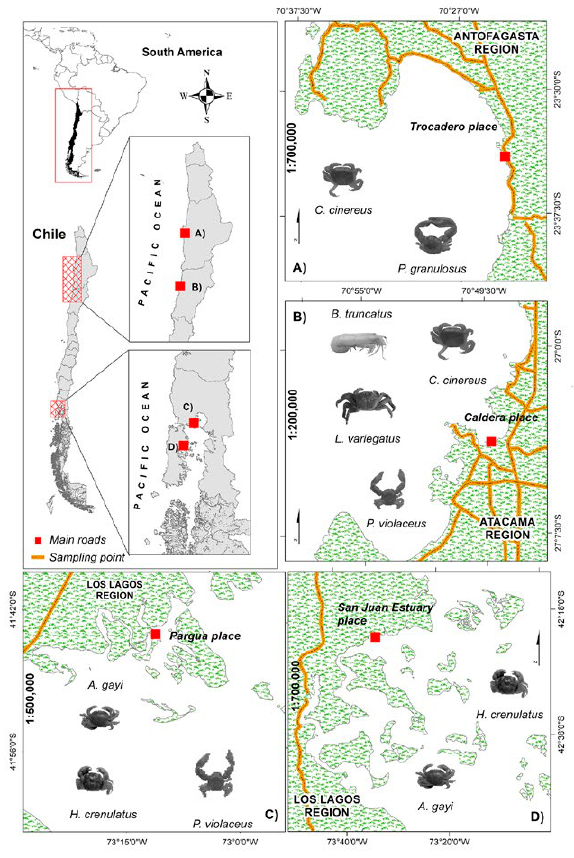
Fig. 1. – Map of sites included in the present